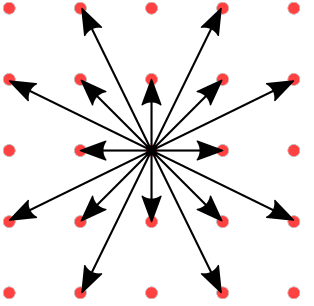
Figure 4. An example of a rule declaring how to connect nodes by edges.